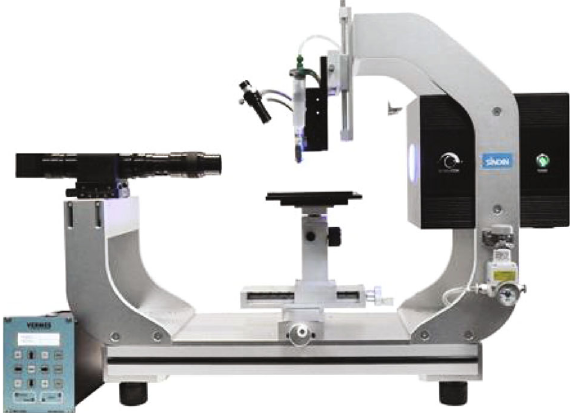
Figure 5: SDC-200S contact angle